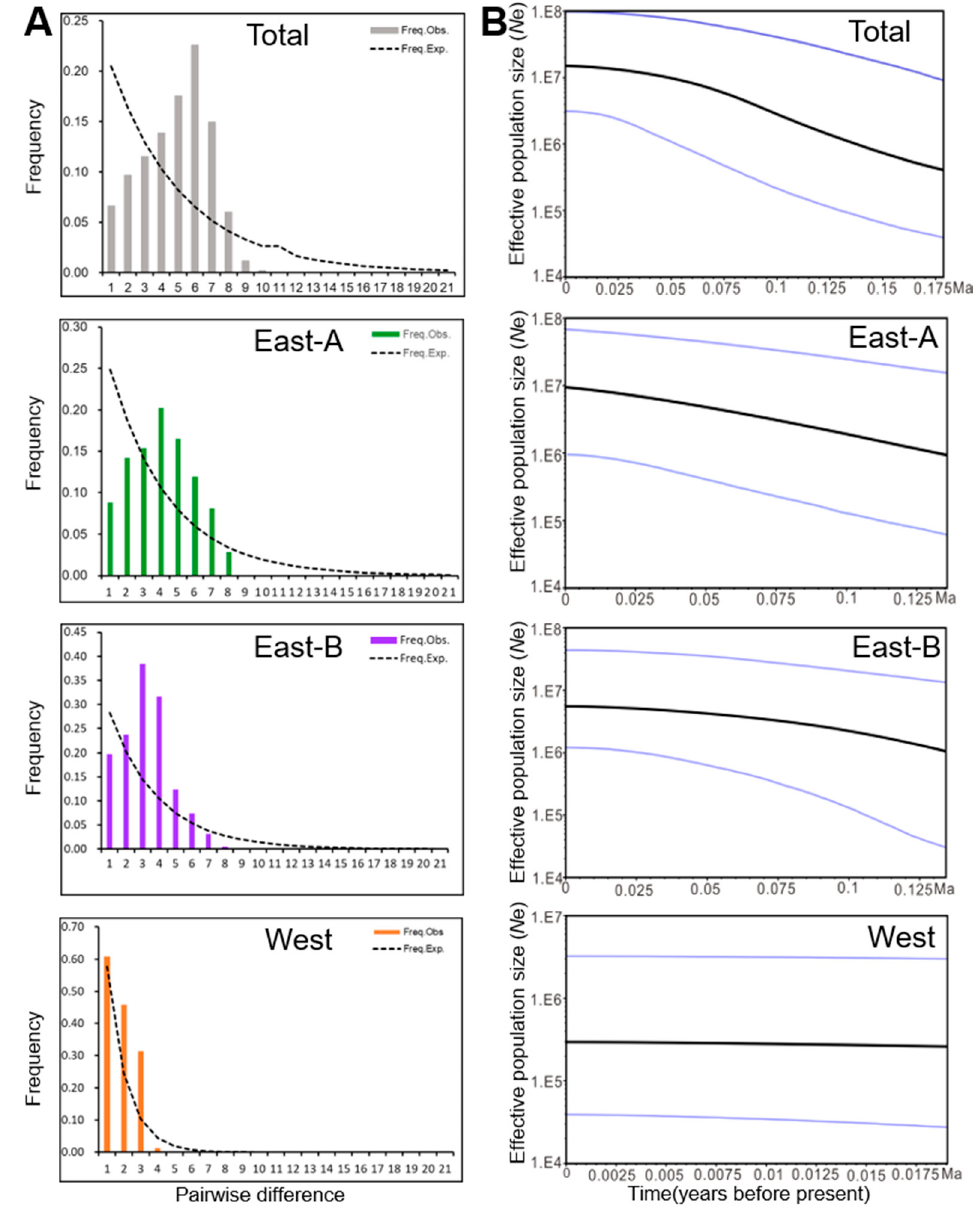
Figure 5. Pairwise nucleotide di ff erences and Bayesian skyline plot (BSP) analysis for the population dynamics of Nitraria tangutorum based on the chloroplast DNA sequencing data. ( A ) Mismatch distribution analysis (MDA) plots for the distribution frequency of pairwise nucleotide di ff erences in total populations or within each lineage of N. tangutorum . The histogram represents the observed distribution of di ff erences among chlorotypes, while the dashed lines illustrate simulated distributions based on a model of sudden (stepwise) demographic population expansion. Freq. obs, frequency of the observed pairwise di ff erences; Freq. exp, frequency of the expected pairwise di ff erences; ( B ) BSP analysis of e ff ective population sizes was determined for the entire population and individual populations of N. tangutorum distributed in the East-A, East-B, and West regions. The solid line indicates the median value, and the area between both blue lines represents the boundary of the 95% central posterior density interval. X-axis: time, years before present (Ma); Y-axis, e ff ective population size ( N e, the product of e ff ective population size and generation length).